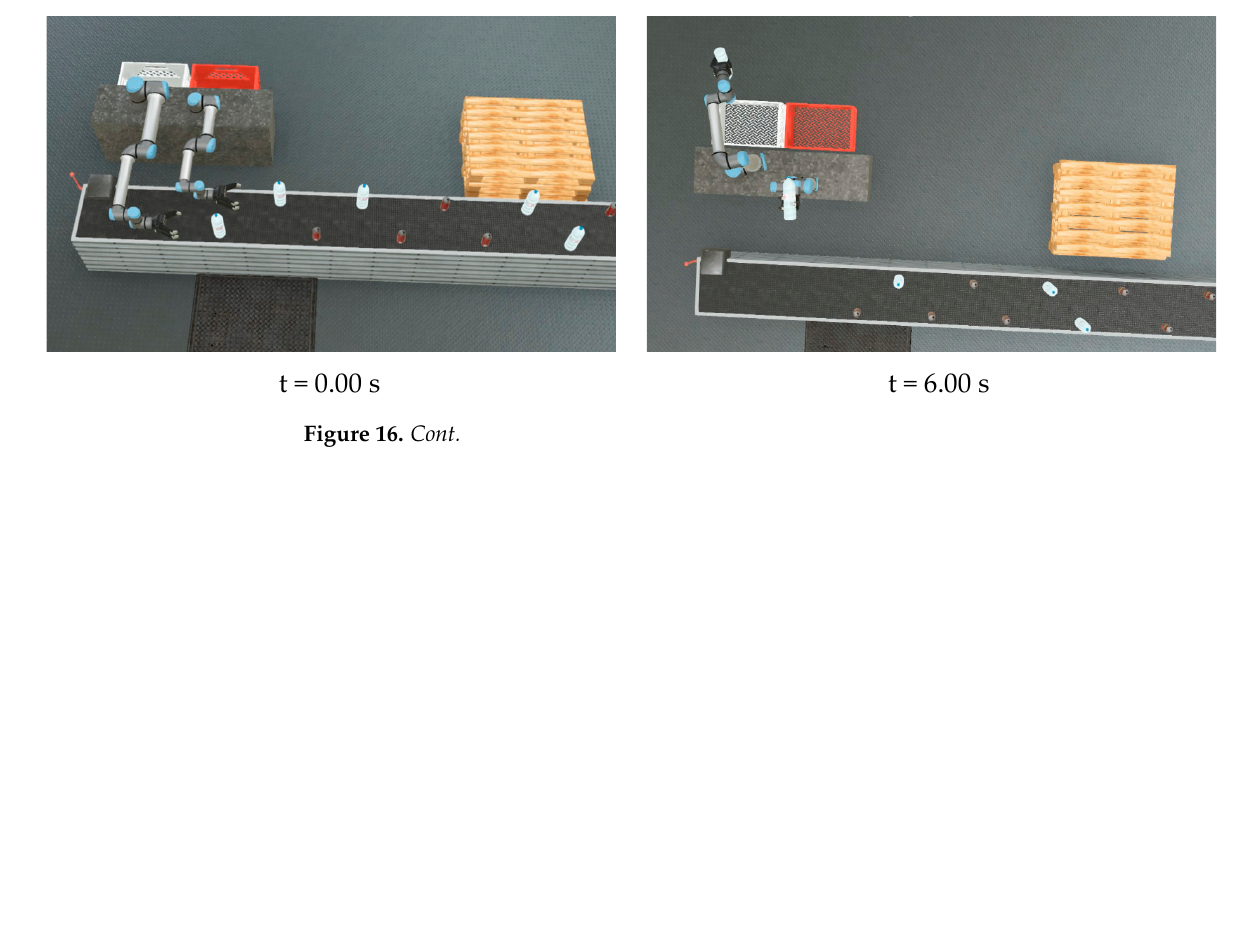
Figure 15. The UML design of the robot software based on the verified model.